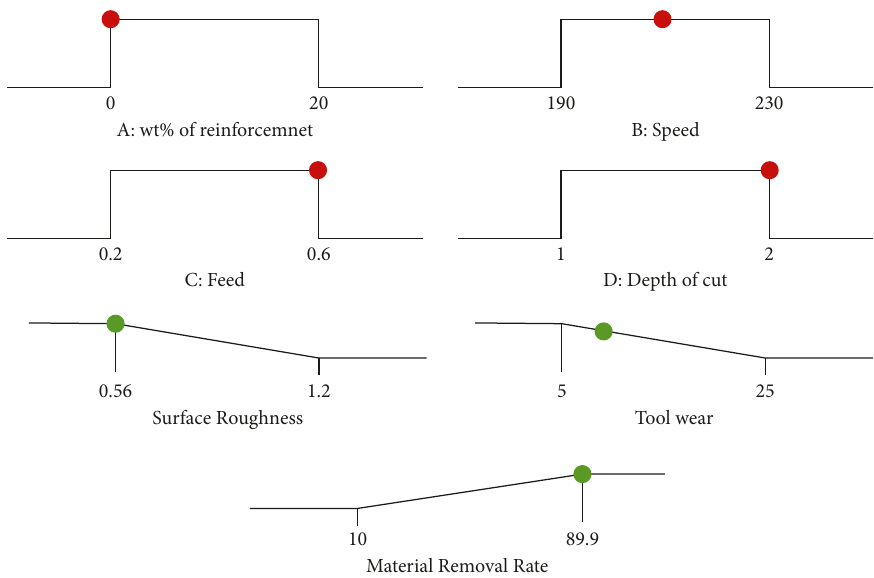
Figure 6: Desirability ramp